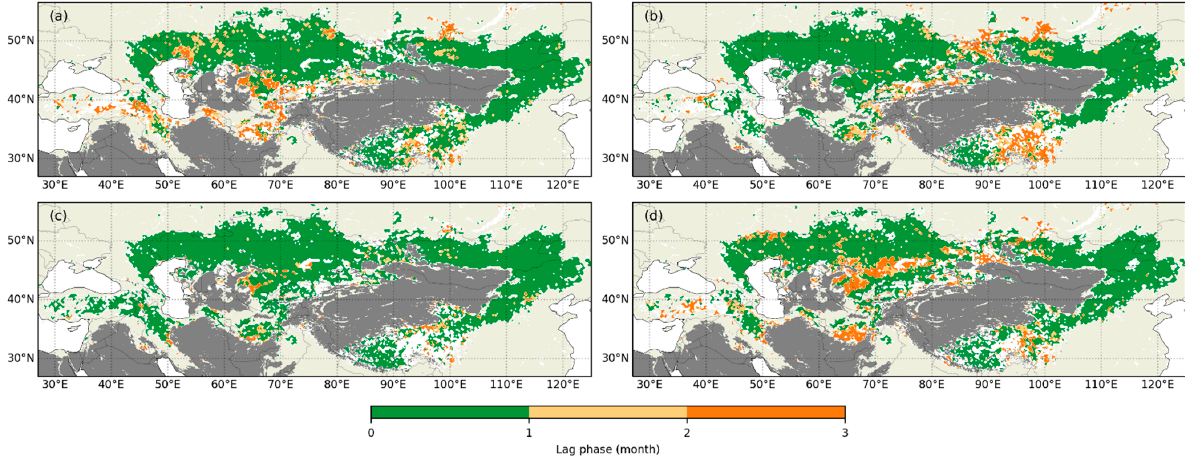
Figure 5. The spatial lag phases of solar-induced chlorophyll fluorescence (SIF) to precipitation (P), vapor pressure deficit (VPD), evaporative stress (ES), and root zone soil moisture (RSM). ( a – d ) were the spatial lag phases of SIF to P, VPD, ES, and RSM respectively.